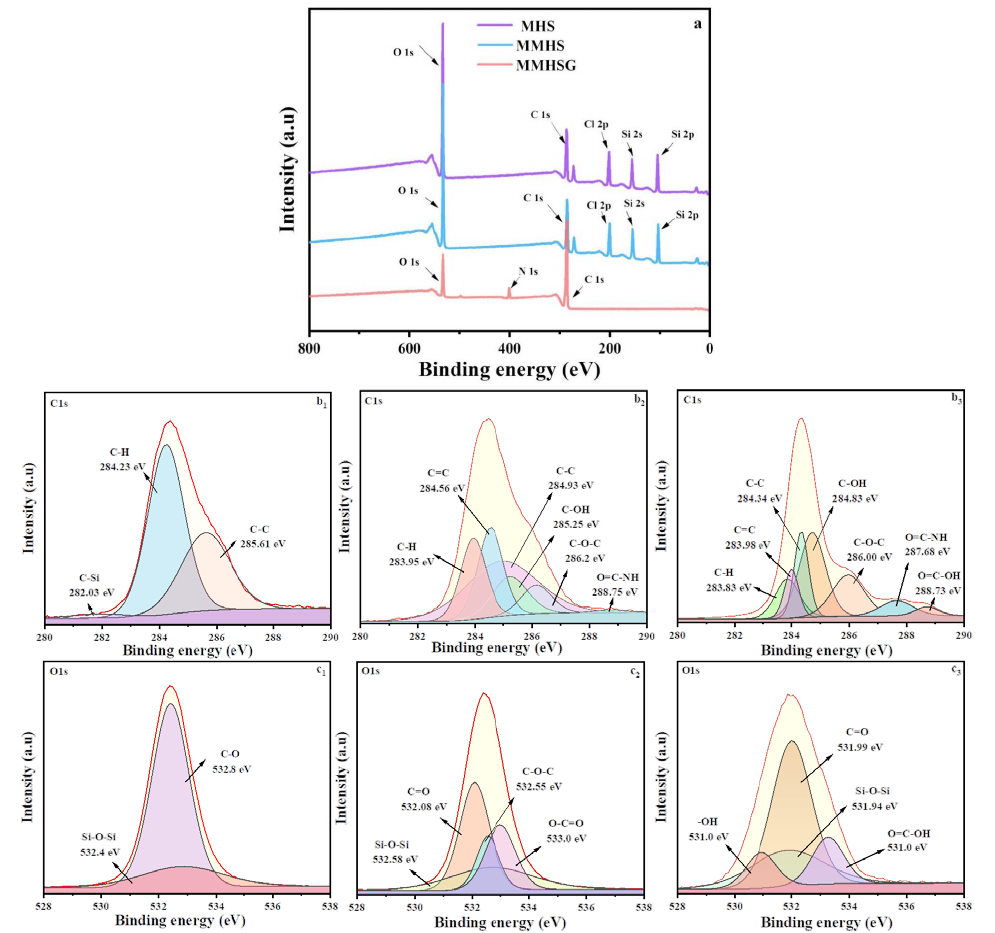
Figure 6. XPS survey spectra of MHS, MMHS, and MMHSG ( a ), and high resolution XPS spectra of C1s and O1s from MHS ( b 1 , c 1 ), MMHS ( b 2 , c 2 ), and MMHSG ( b 3 , c 3 ). Moreover, thermal decomposition behavior analysis (TGA) was conducted to ana- lyze the content of each component in MMHSG (Figure 7). When the temperature in- creased from 25 °C to 100 °C, the weight loss of water in MMHSG was about 8%. When the temperature increased to 400 °C, there was no significant loss of MHS and MMHS, which proves the high thermal stability of MHS and MMHS. In addition, 32% loss of MHS between 400 °C and 800 °C was mainly due to the decomposition of Si-OH and -Cl on its surface [48], whereas MMHS lost 8% more on this basis, which should be caused by the decomposition of graft MIPs. Meanwhile, the second weight loss of MMHSG was due to the loss of the hydrogel network with the decomposition of MMHS’s surface imprinted polymers, accounting for about 72%. Figure 7. TGA curves of MHS, MMHS, and MMHSG.